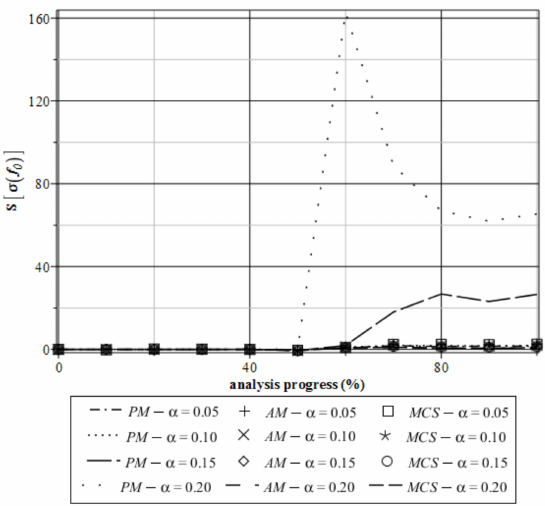
Figure 13. Skewness of the extreme von Mises stress S[ σ (f 0 )] for the specimen.